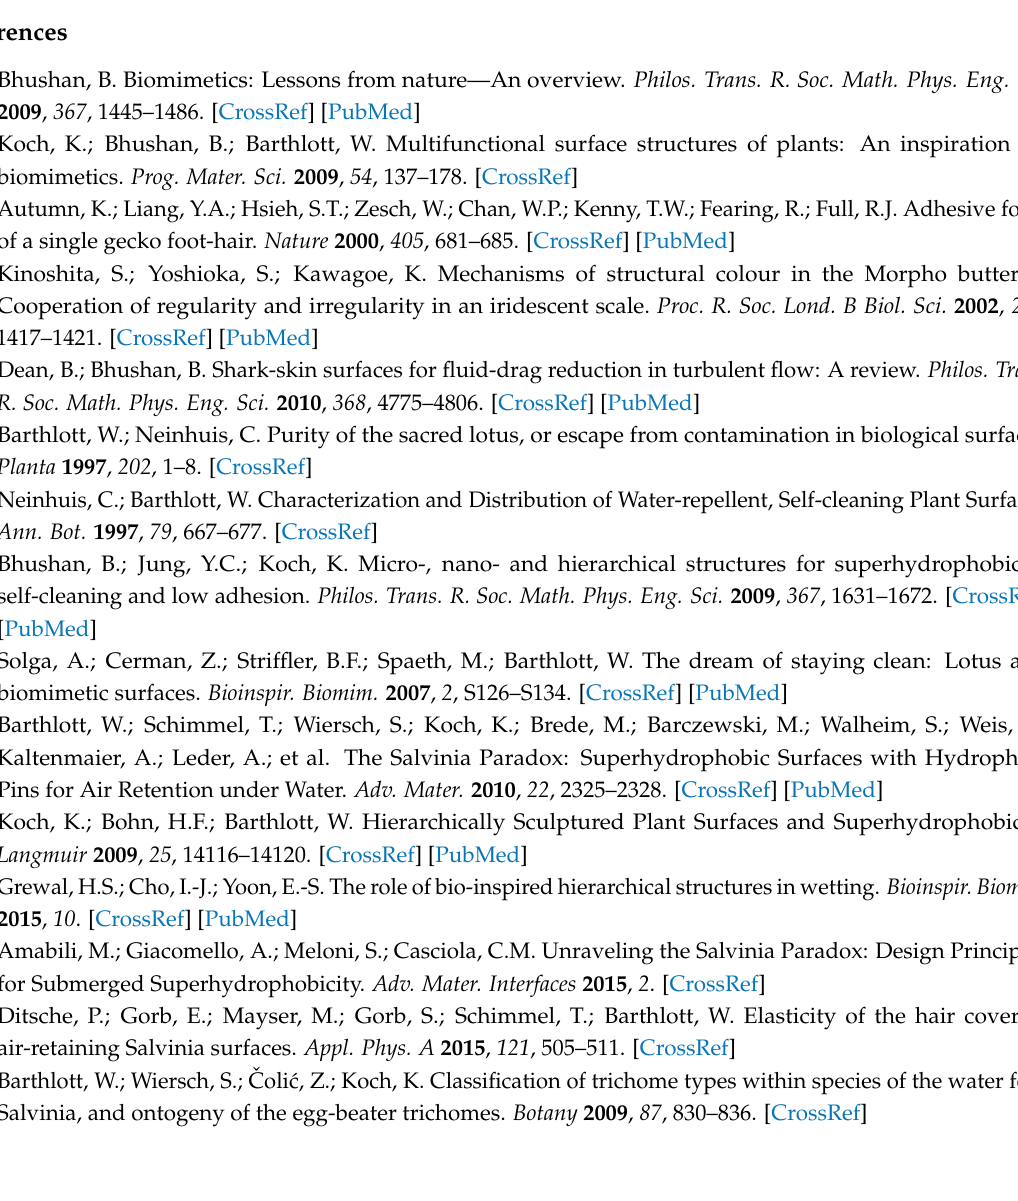
Figure S1: SEM images of design 1 (a,b); 2 (c,d); 3(e,f); 7 (g,h); 8 (i,j); 9 (k,l); 13 (m,n); 14 (o,p); 15 (q,r). Designs refers to table in Figure 1d, Figure S2: (a) Static contact angle of water on flat SU-8; (b) Static contact angle of water with 5(6)-TRITC (0.01 mg · mL − 1 ) on flat SU-8, Figure S3: (a–e) Results of the dynamics of the variation of the air volumes trapped in the salvinia-like structures for all the tested designs (see Figure 1d), grouped for crown-like radius heads. N represents the number of filaments composing the crown-like heads while R is the radius of the heads, Figure S4: (a–c) Results of the dynamics of the variation of the air volumes trapped in the salvinia-like structures for all the tested designs (see Figure 1d), grouped for number of crown-like heads filaments. N represents the number of filaments composing the crown-like heads while R is the radius of the